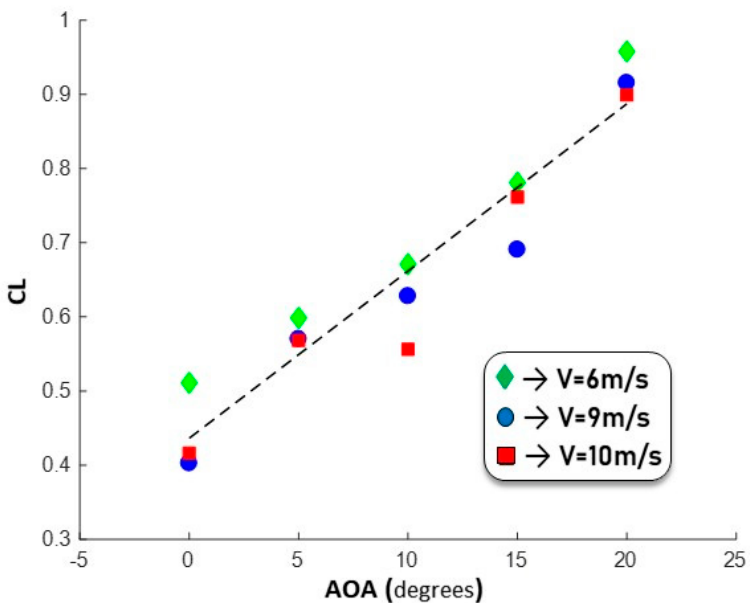
Figure 8. Inflatable wing lift Curve (CL-Alpha) as a function of the angle of attack.